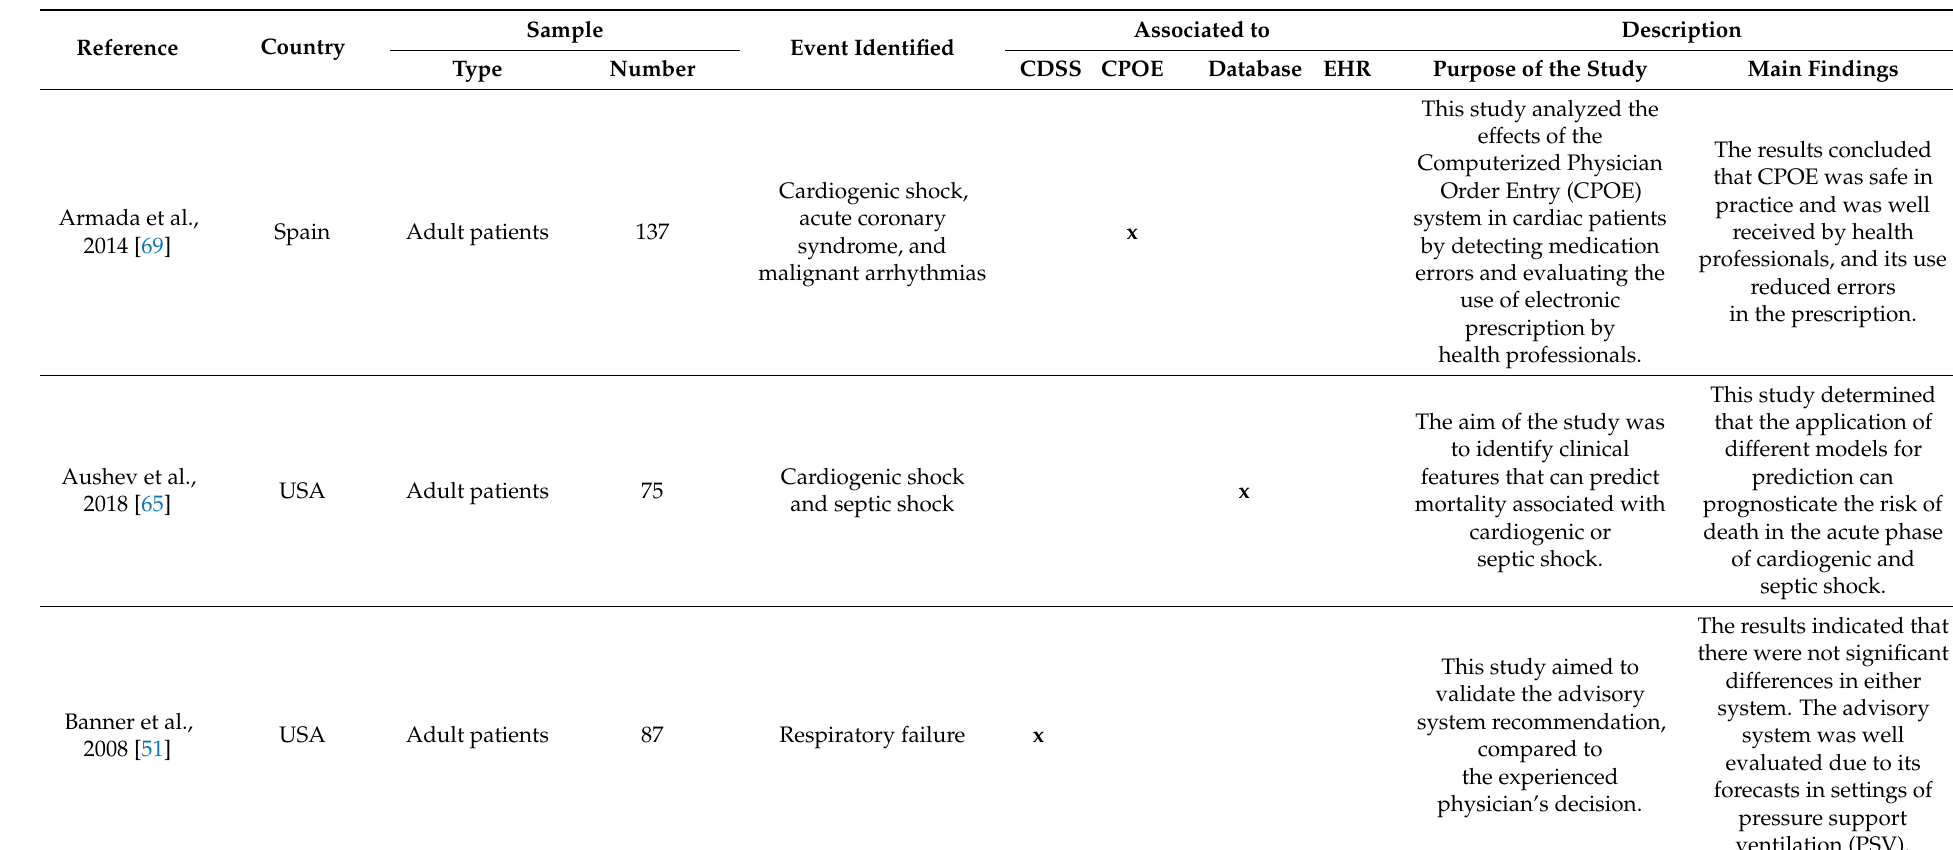
Table 1. Summary of the data extracted from the 22 selected